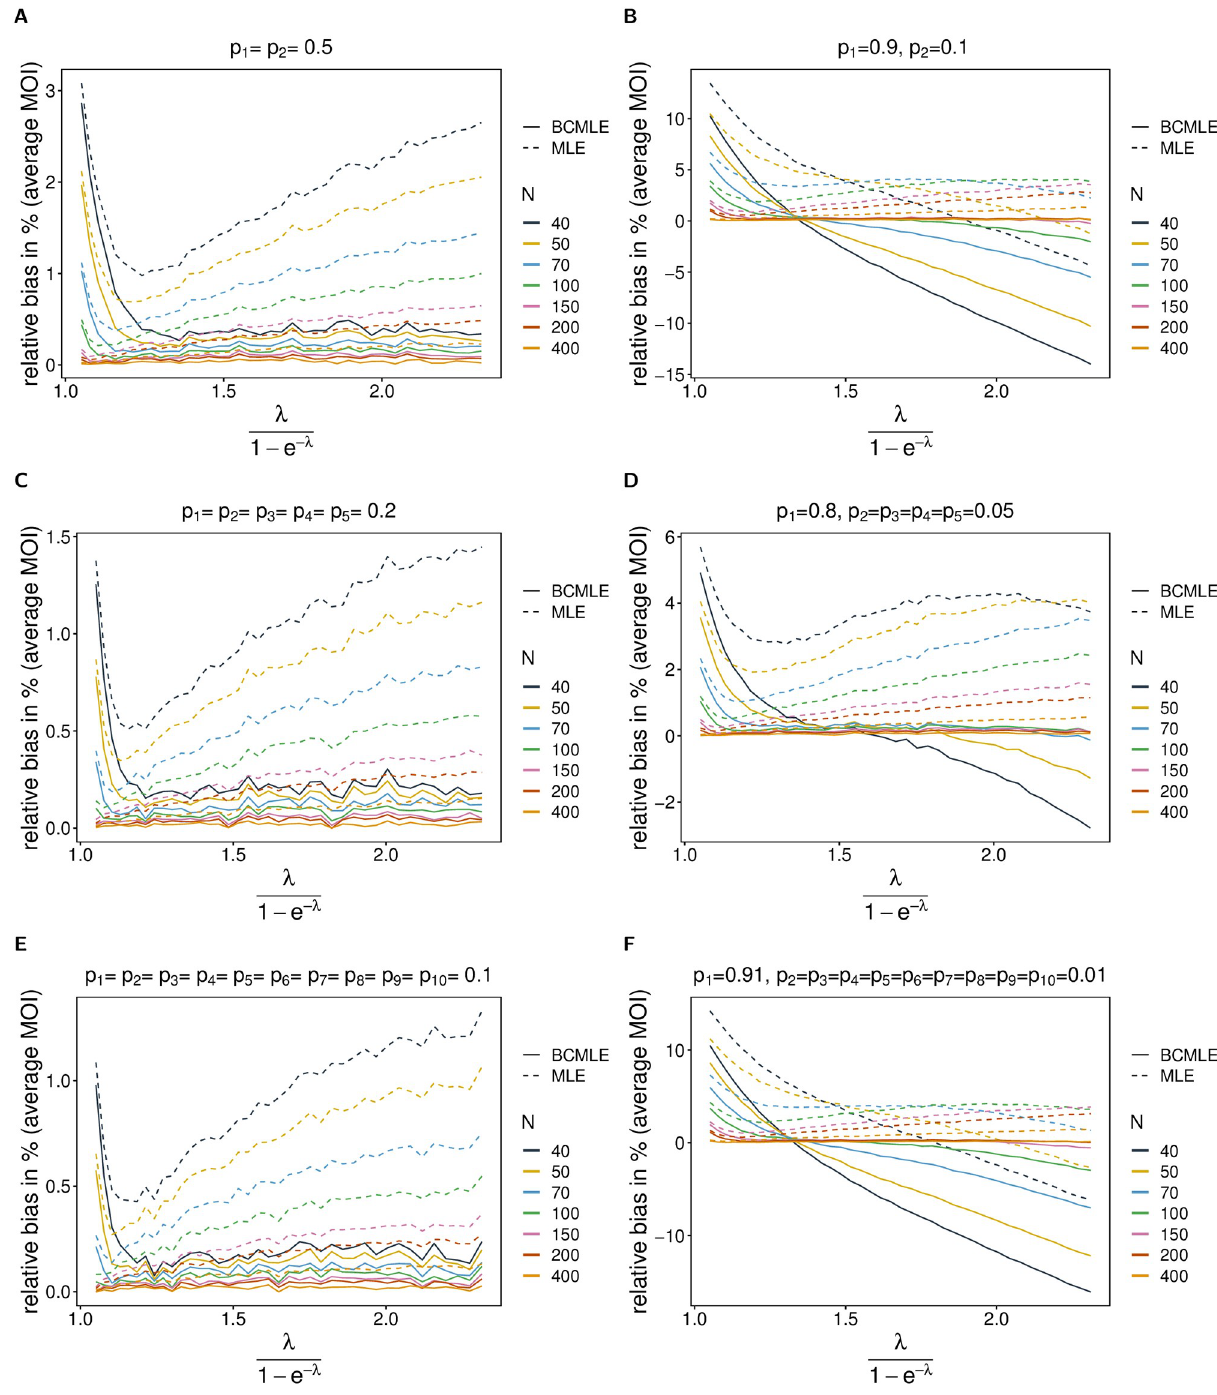
Fig 2. Bias of MOI estimates. The figure shows the relative bias in % of the BCMLE ^ c ð bc Þ (solid lines) and MLE ^ c (dashed lines) as a function of the true parameter ψ based on simulated data created by the conditional Poisson model. Each panel assumes a different lineage-frequency distribution p shown at the top of each panel. Each colored line corresponds to a different sample size N .